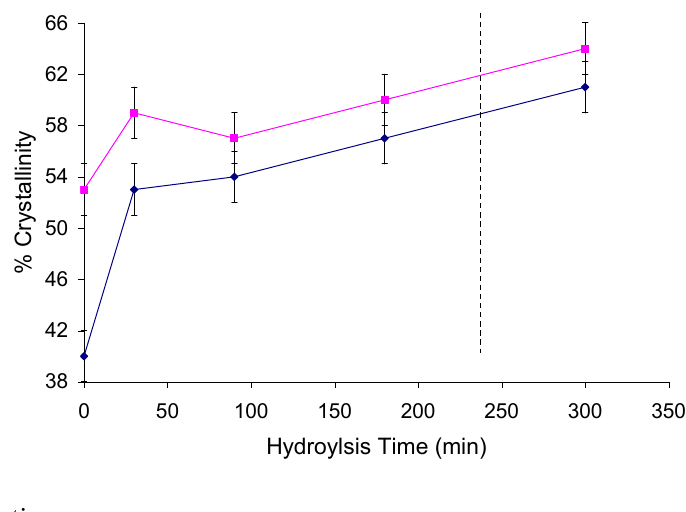
Figure 4. Degree of crystallinity of cellulose from a Populus standard after holocellulose pulping and hemicellulose removal by acid hydrolysis in 2.5 M HCl at various residence times as measured by a 13 C CP sequence ( ♦ ) and 13 C CP sequence with 6.5 ms 1 H spin-lock filter ( ■ ). The dotted line represents the normal 4 h reaction time for hemicellulose removal typically employed. The error bars represent thee standard deviations of typical variation associated with the